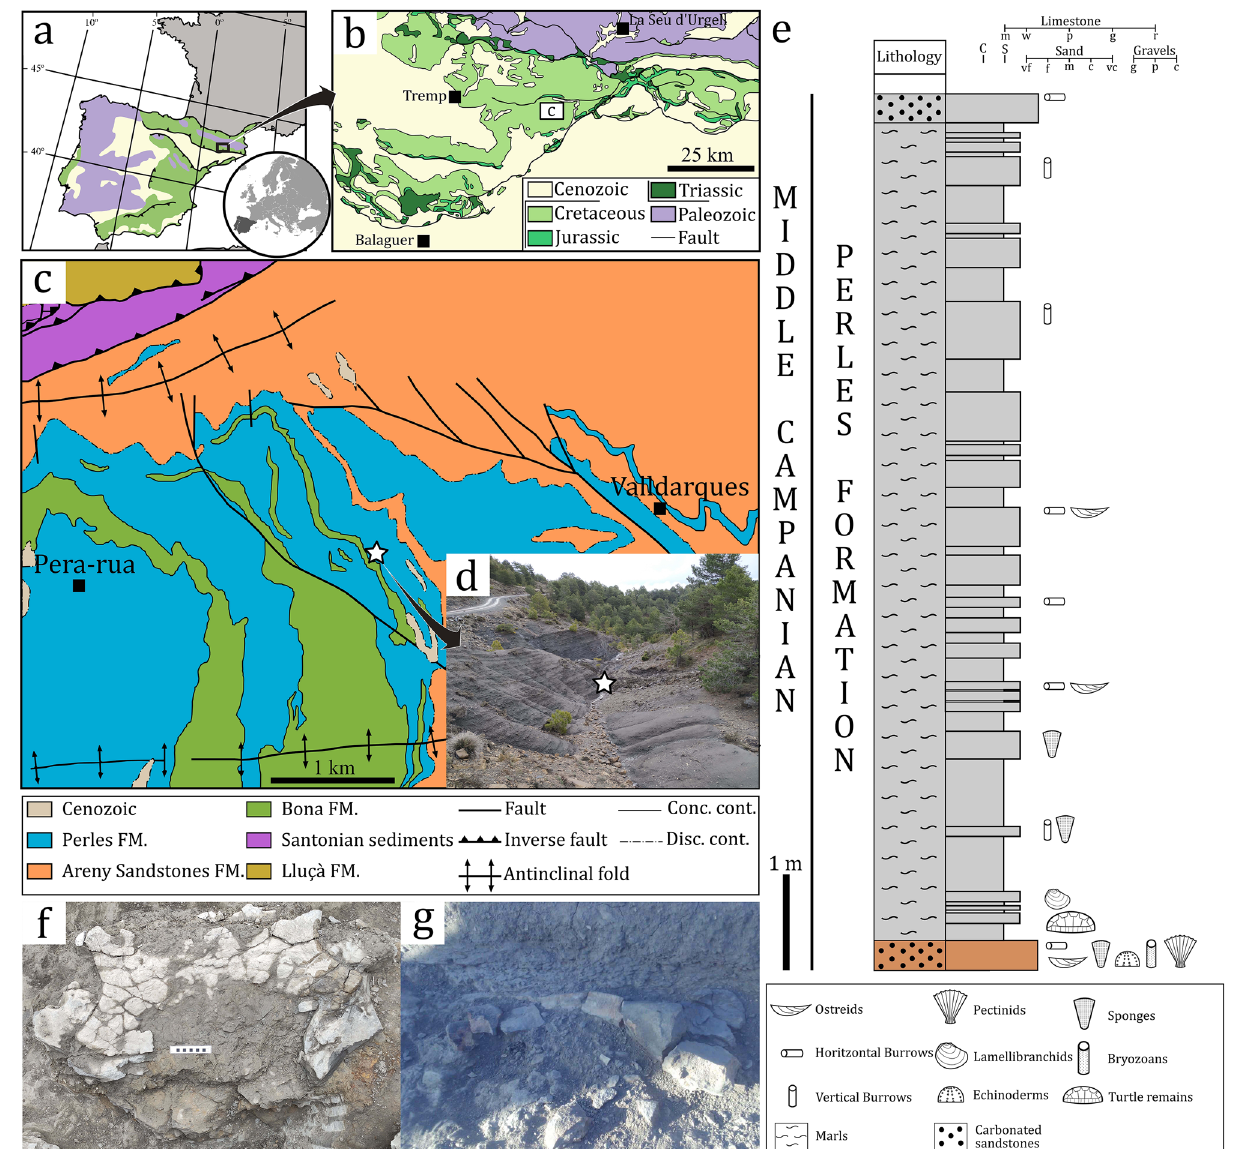
Figure 1. Geographic and geological situation of Cal Torrades. The Cal Torrades fossil locality location, respect: ( a ) the Iberian Peninsula; and ( b ) the Eastern Pyrenees. ( c ) Simplified geological map including the locality (white star). ( d ) Field capture of Cal Torrades outcrop, marking with the star the location of the fossil remains: ( e ) pelvis; and ( f ) ilium. ( g ) Locality stratigraphic column with the geological materials and fossil remains. Modified from Costantino and Angelini 26 , Vidal 27 and free access digital maps of the Institut de Cartografia i Geologia de Catalunya (ICGC; http:// www. icc. cat/ vissi